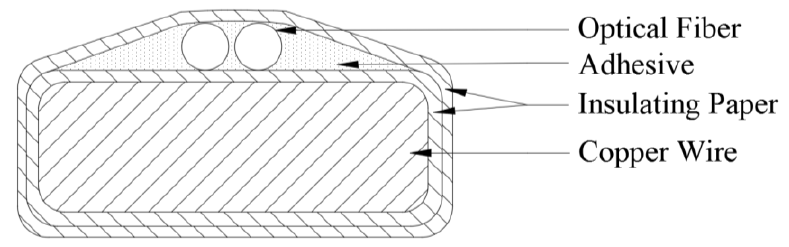
Figure 5. Built-in fiber winding cross-section.